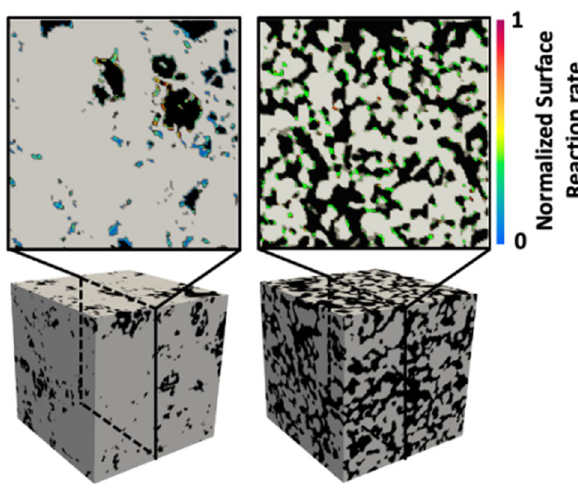
Figure 1. The normalized local surface reaction rates shown in 2D slices (top) of two different 3D porous media